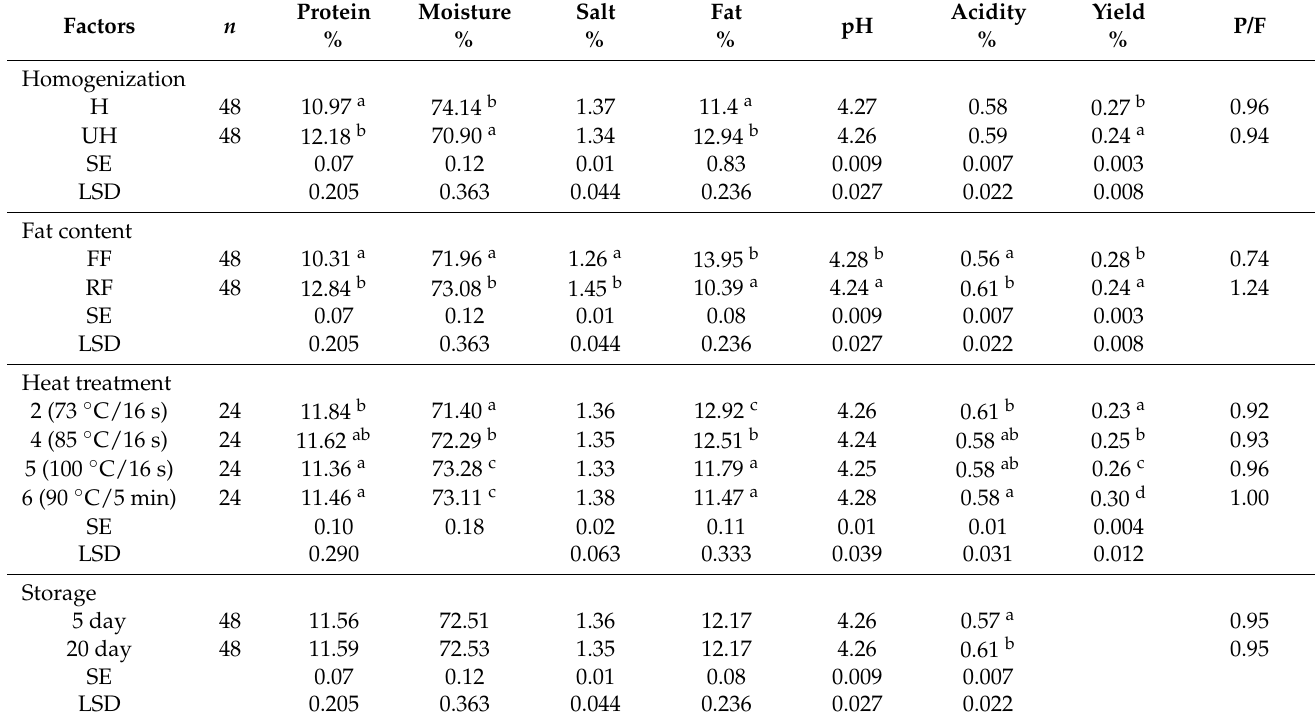
Apparently, the fat reduction of cheese milk significantly ( p < 0.05) affected p < the parameters of Table 2. On average, full-fat (FF) cheeses contained 71.96% moisture, 13.95% fat, 10.31% protein, and 1.26% salt. The respective contents for the reduced-fat (RF) coun- terparts were 73.08%, 12.84%, 1.45%, and 10.39%. The protein-to-fat ratios were lower